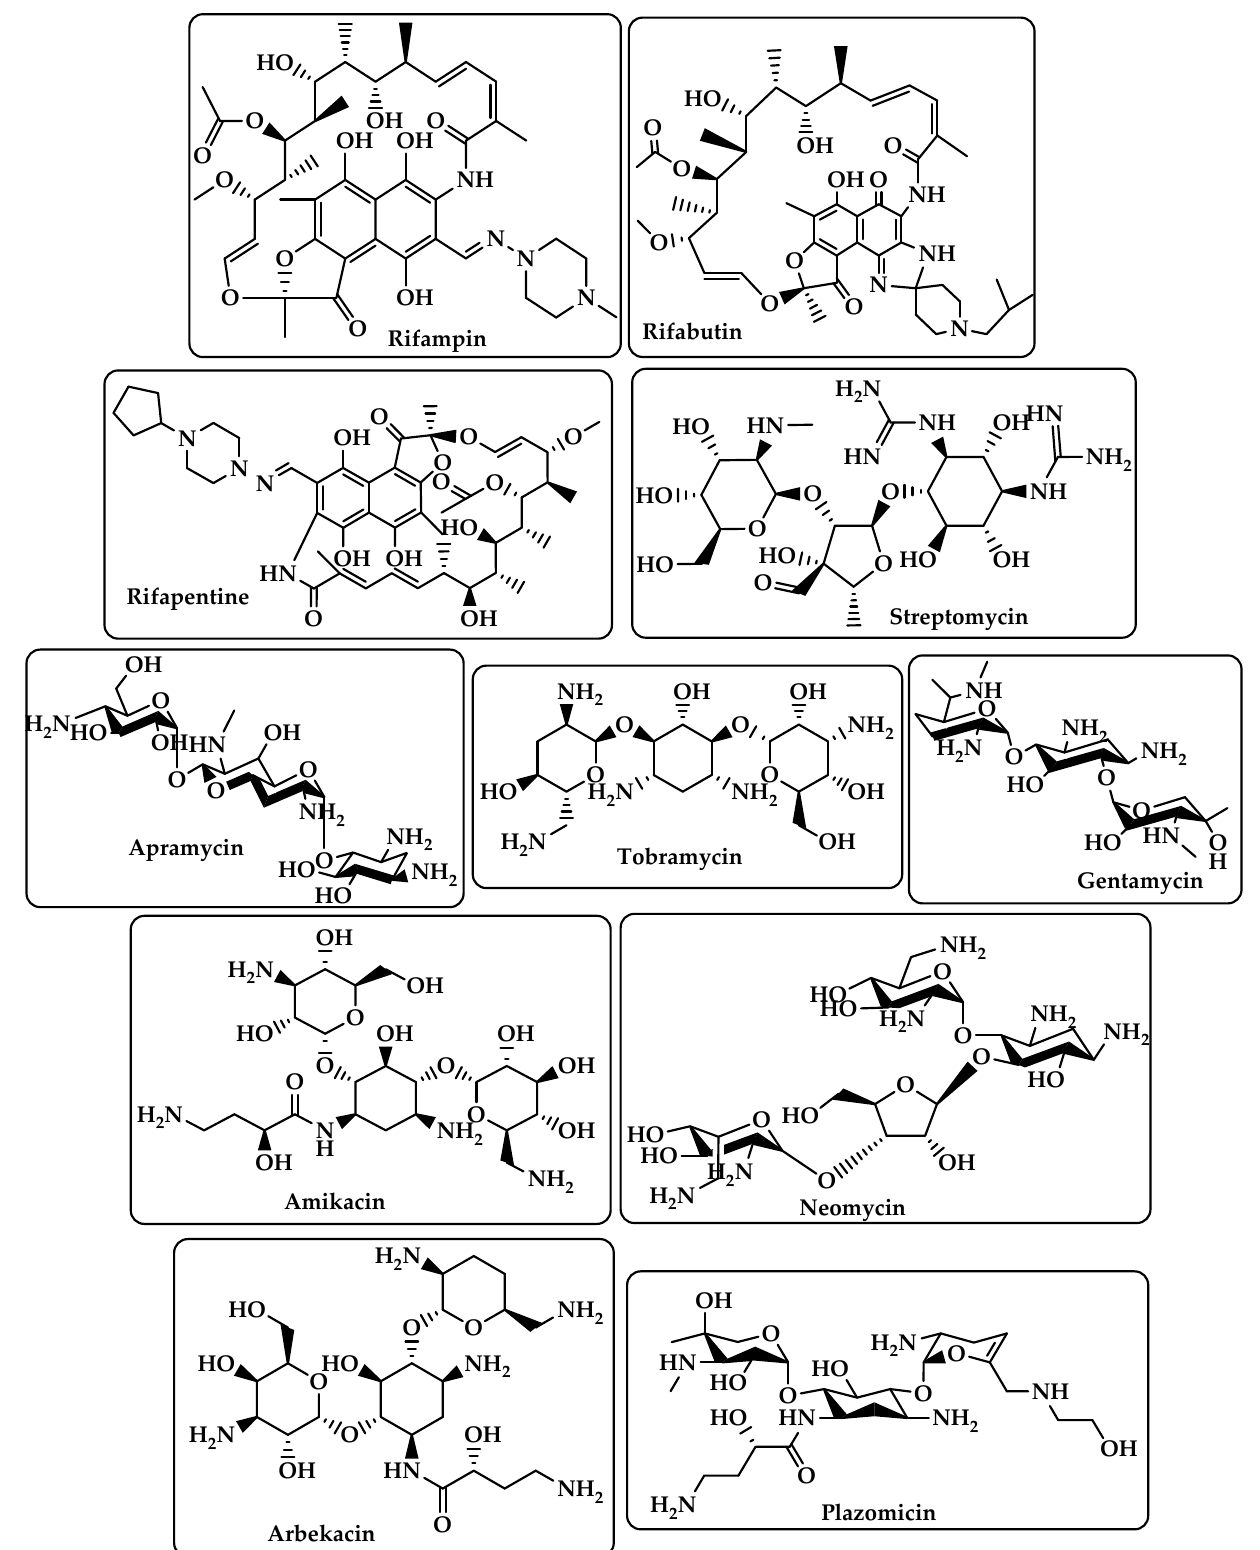
Figure 3. Chemical structure of rifampin, rifabutin, rifapentine, streptomycin, apramycin, tobramycin, gentamycin, amikacin, neomycin, arbekacin, and plazomicin.